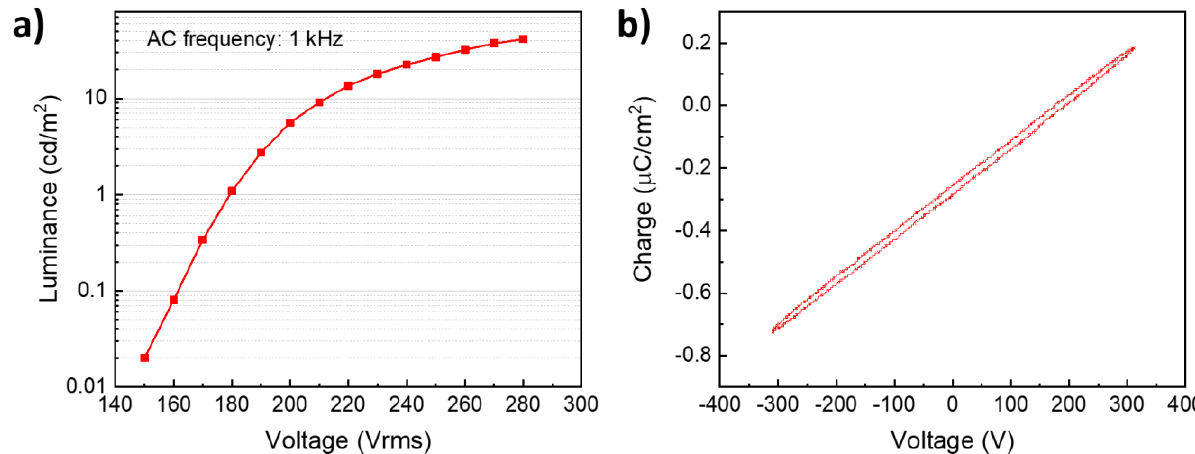
Figure 5. ( a ) Luminance versus the applied voltage and ( b ) charge–voltage (Q-V) characteristics for the Y 2 O 3 :Eu/ZnS electroluminescent device under a sinusoidal wave with a frequency of 1 kHz.